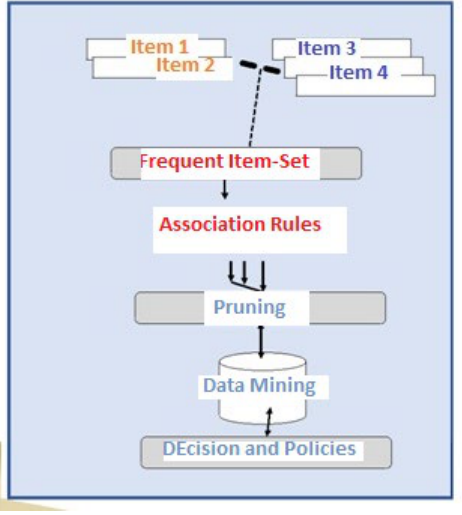
Figure 2 : Intelligent Inferences and Predictions from User dataset